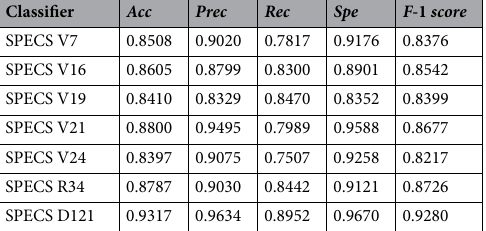
Table 7. Experimental results on evaluation metrics for test samples in dataset D 2 .